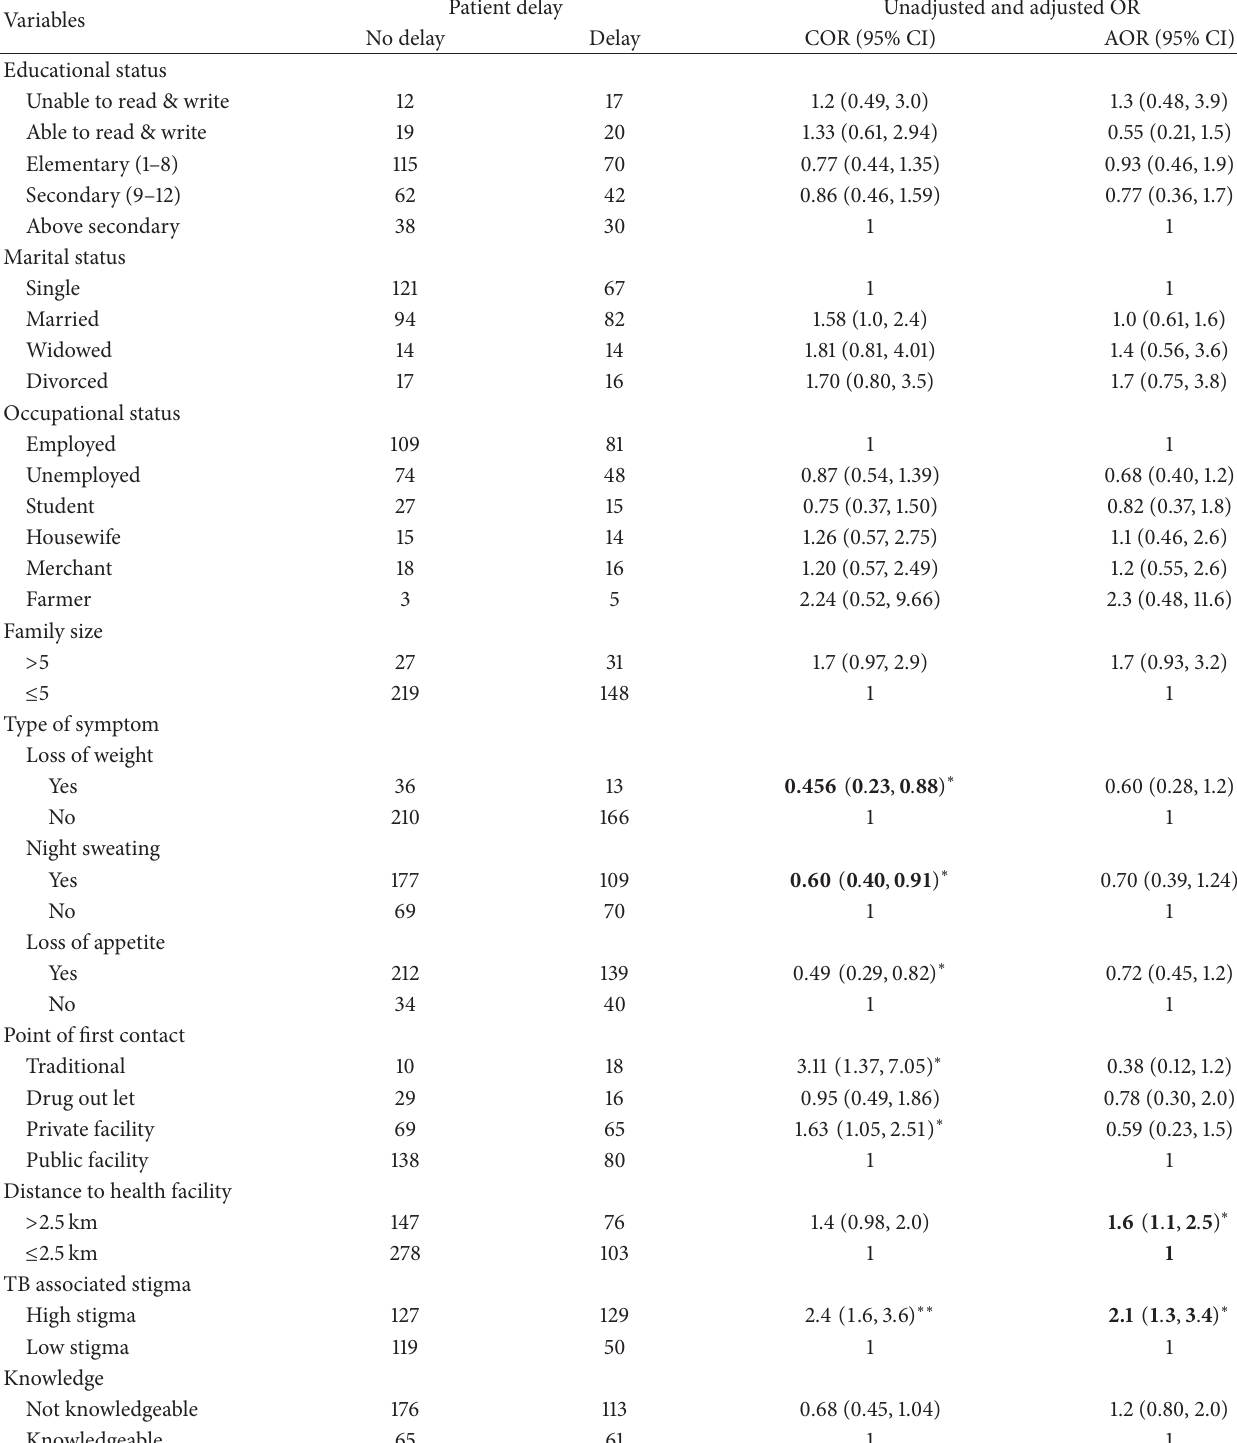
Table 3: Factors associated with patient delay for treatment of PTB among pulmonary TB patients, Addis Ababa, 2012.